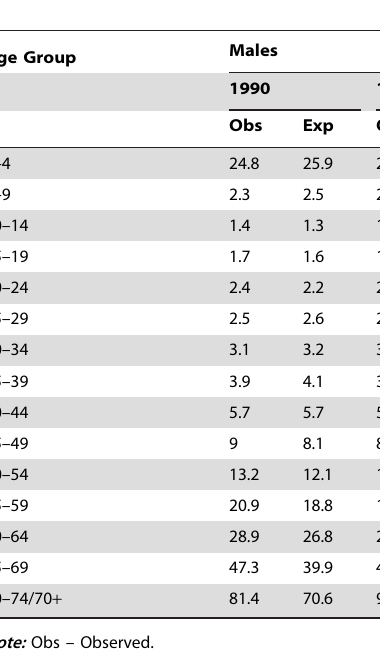
Table 3. Observed and expected age specific death rates for India.